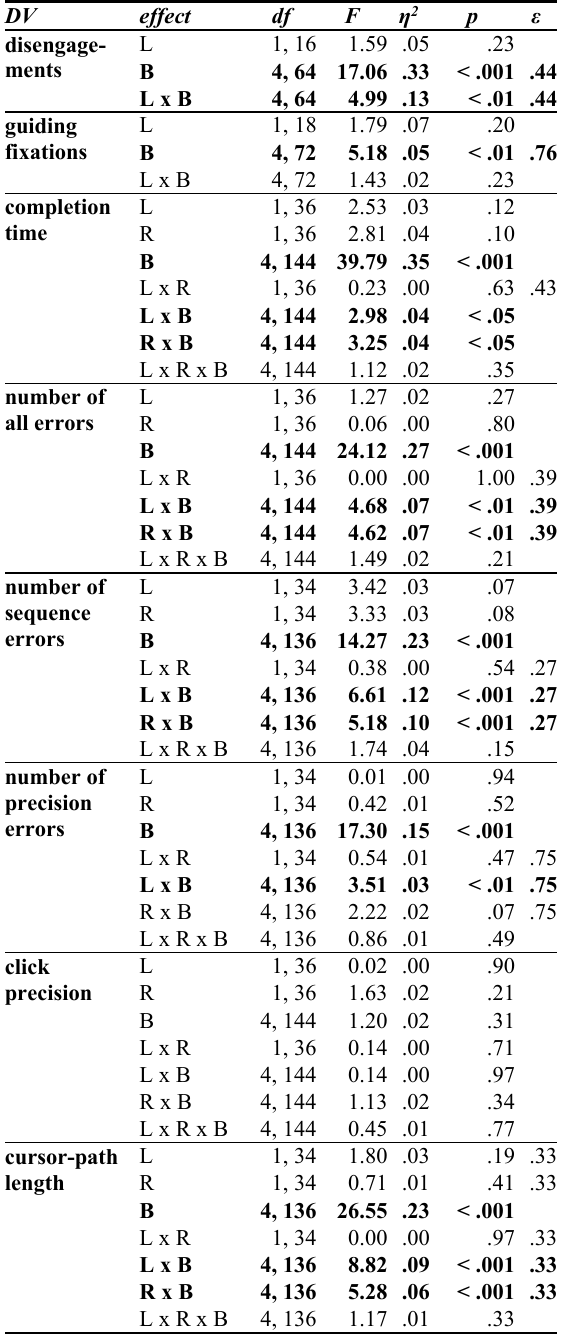
Table 2. ANOVA results of the recall phase of Experiment